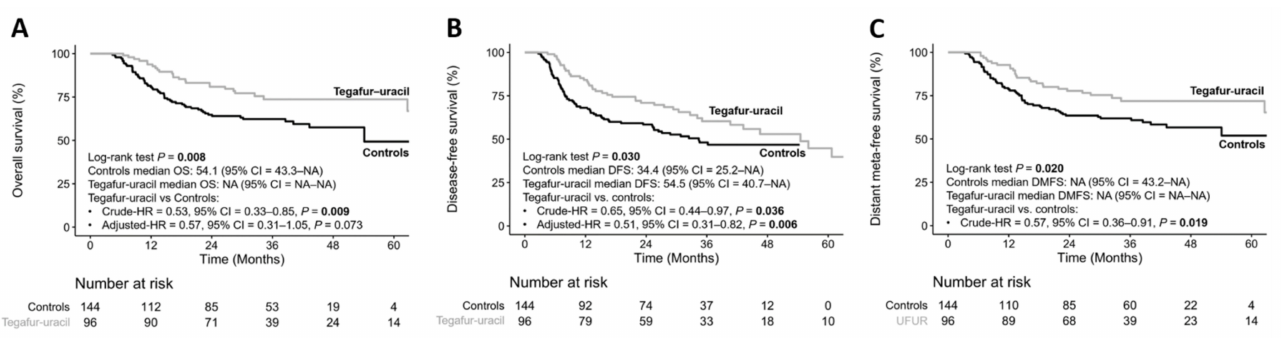
Figure 1. Kaplan–Meier plot for overall survival ( A ), disease-free survival ( B ), and distant metastasis-free survival ( C ).